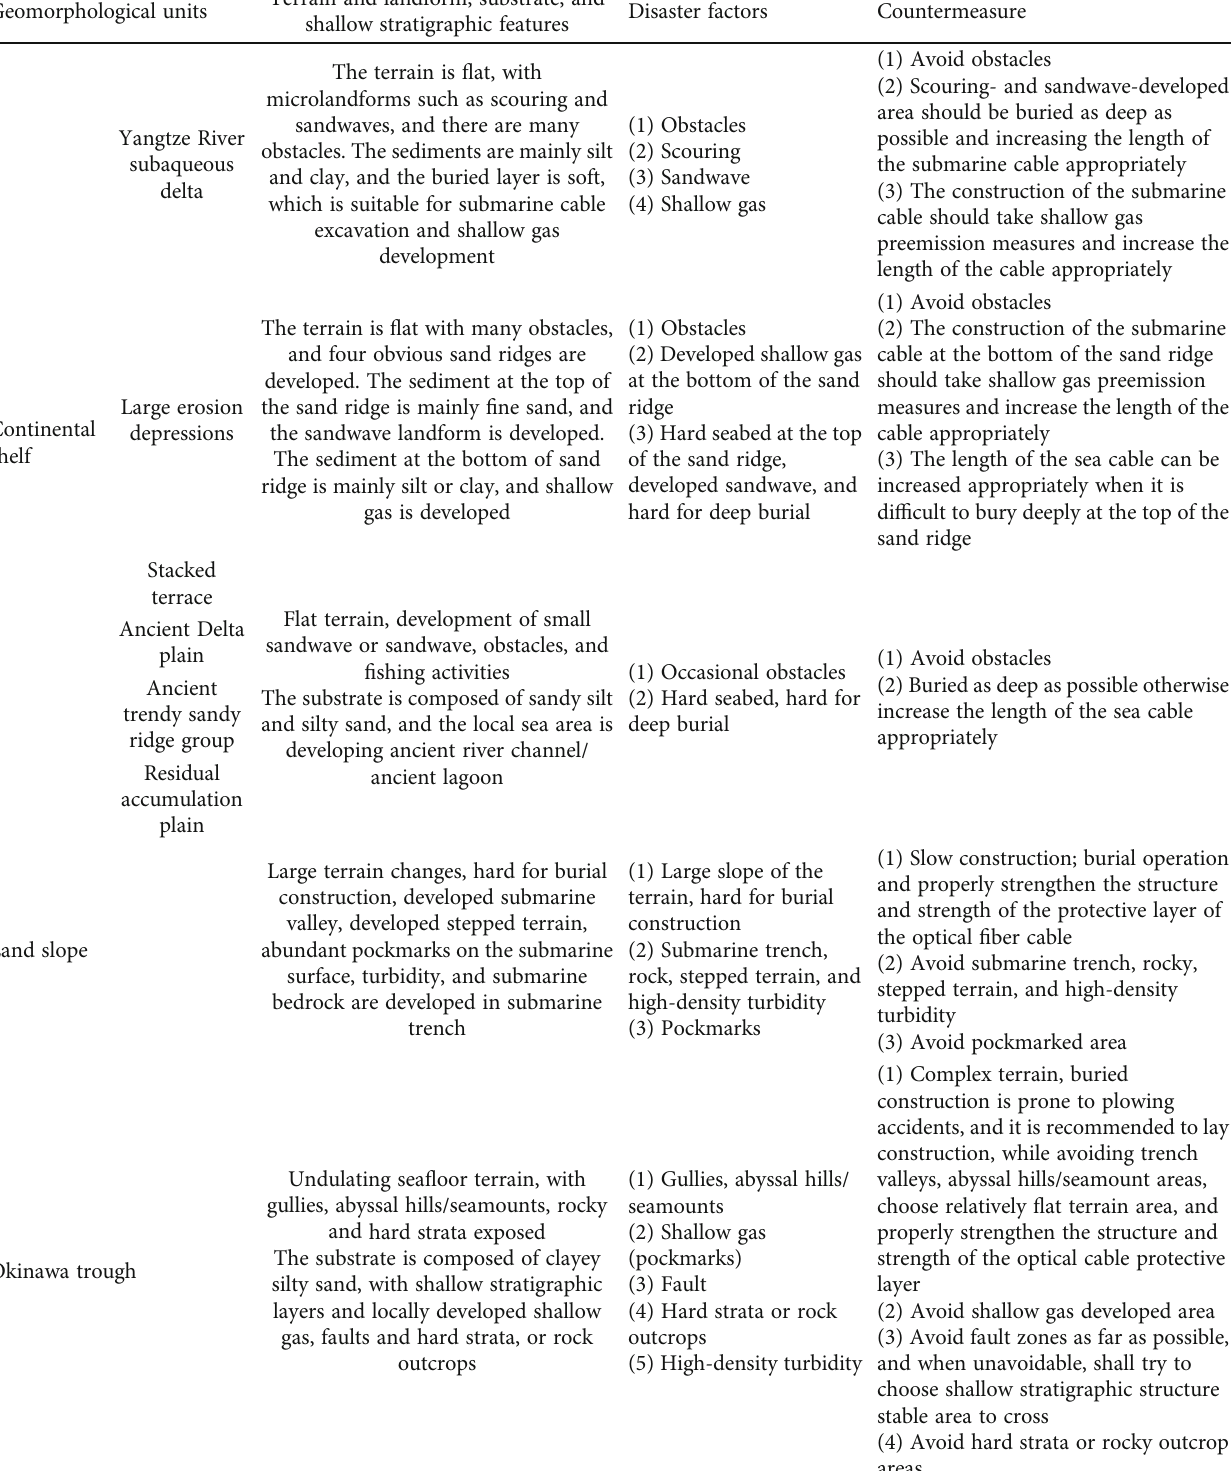
Table 1: Evaluation results of geological engineering conditions of each geomorphological unit in the routing